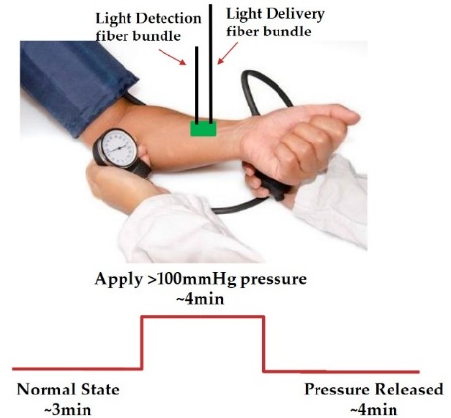
Figure 7. Set-up and protocol for blood pressure tests.